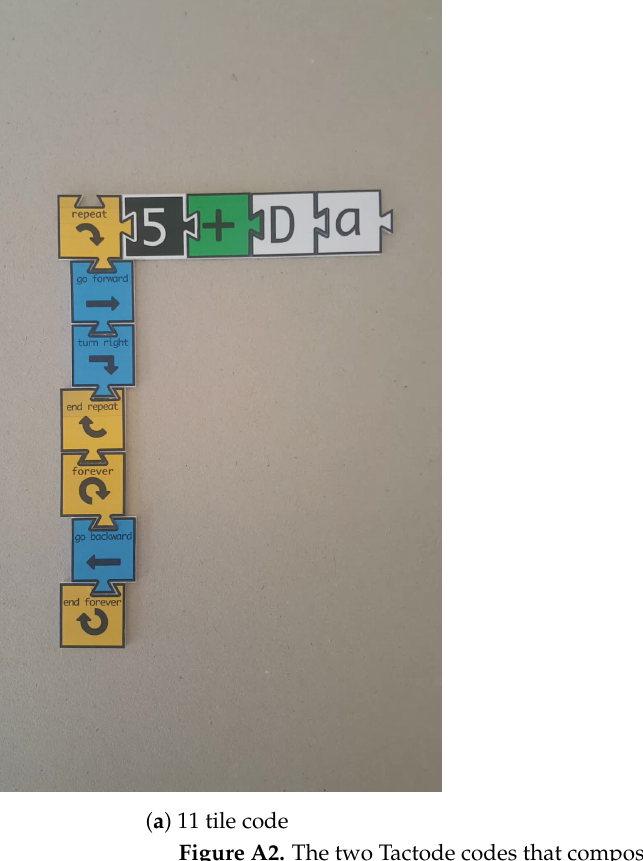
Figure A2. The two Tactode codes that compose the tactode_big test dataset.